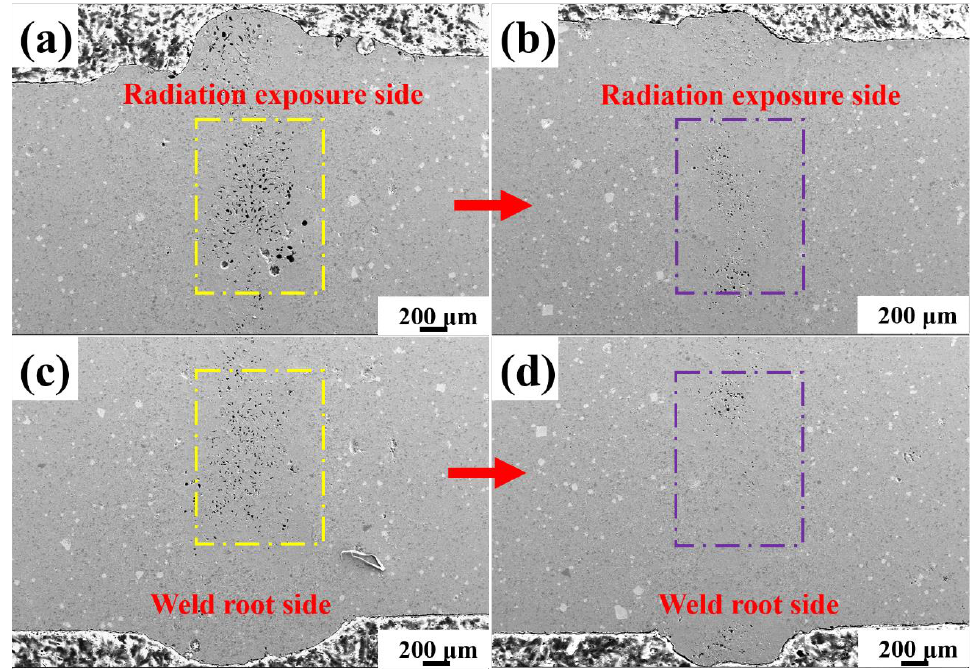
Figure 2. SEM image of 20 vol%SiC/2A14 joint cross section. ( a , c ) Representative sample Y1; ( b , d ) Representative sample Y2.